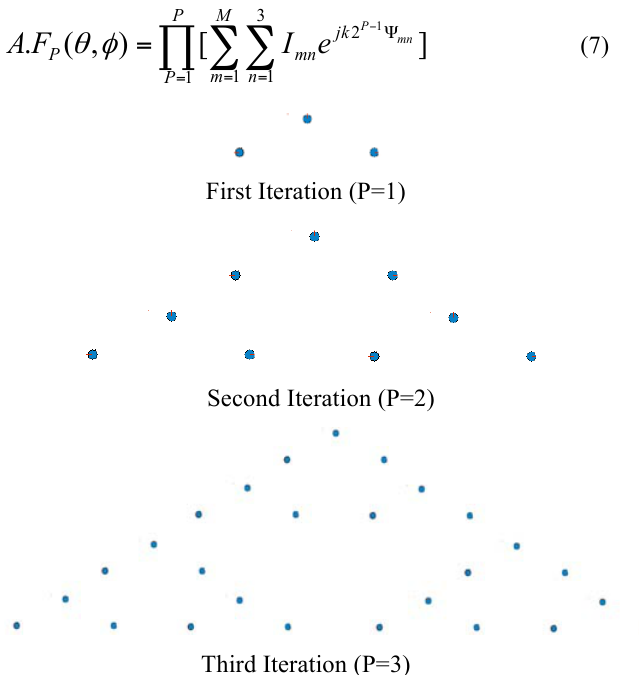
Figure 5. First three iterations of triangular planar fractal array antenna for an expansion factor of